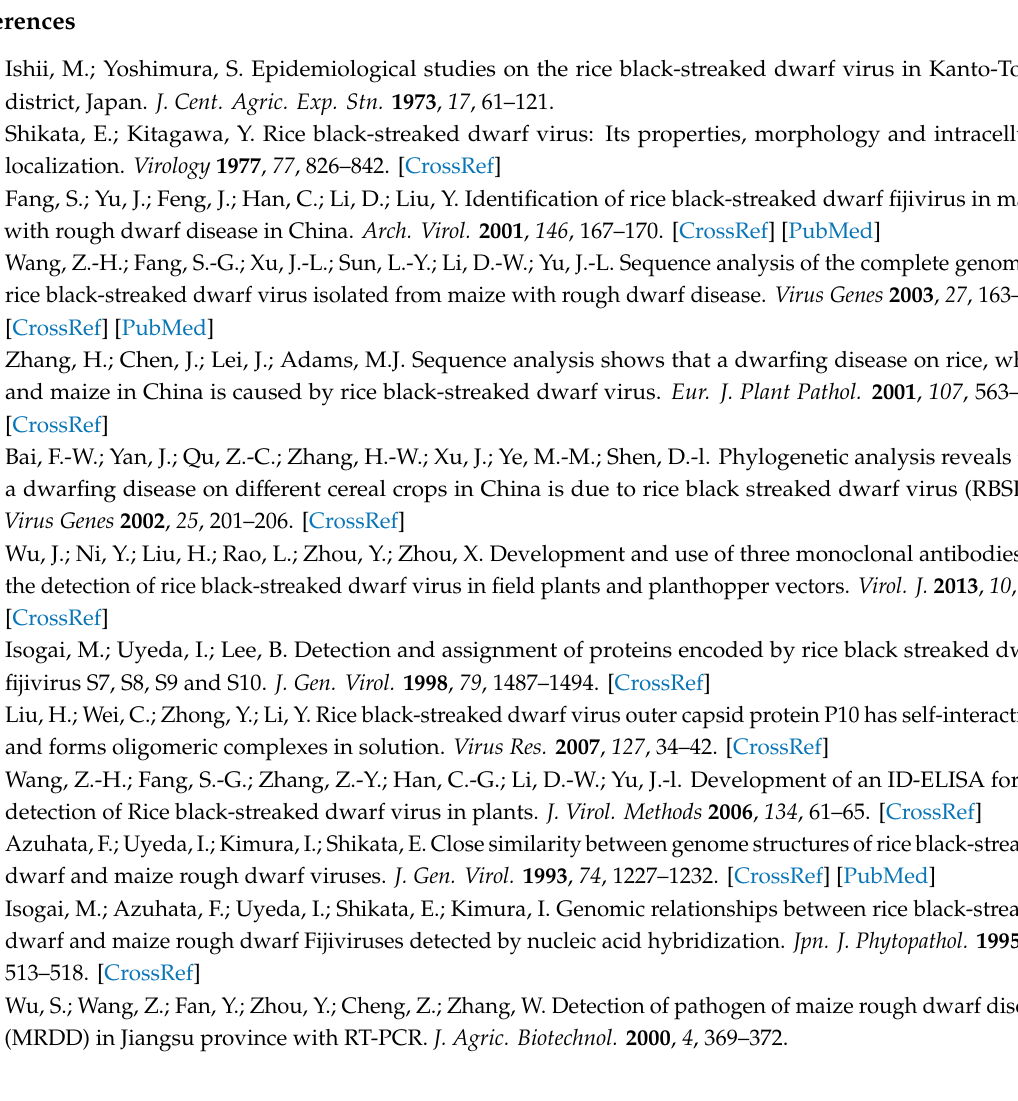
Figure S1: Induction of the RBSDV P10 protein by di ff erent protein expression constructs. Figure S2: Expression and purification of the RBSDV His-P10 protein. Figure S3: Optimization of emulsion creation process and BSA concentration for ePCR. Figure S4: Uncropped figures (all 46 panels) of Figure 7. Figure S5: Uncropped figures (all 32 panels) of Figure